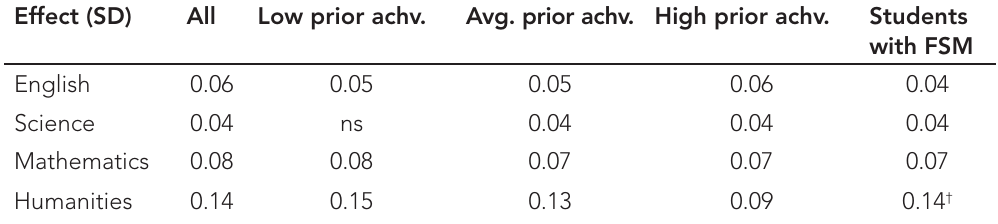
Table 3: Effect of one additional hour per Year 11 class, by sub-group